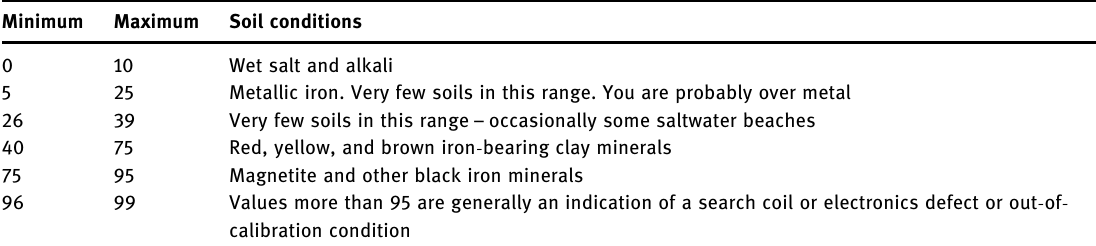
Table 1: Estimated ranges of ground balance readings for soil conditions ( First Texas Products, 2015